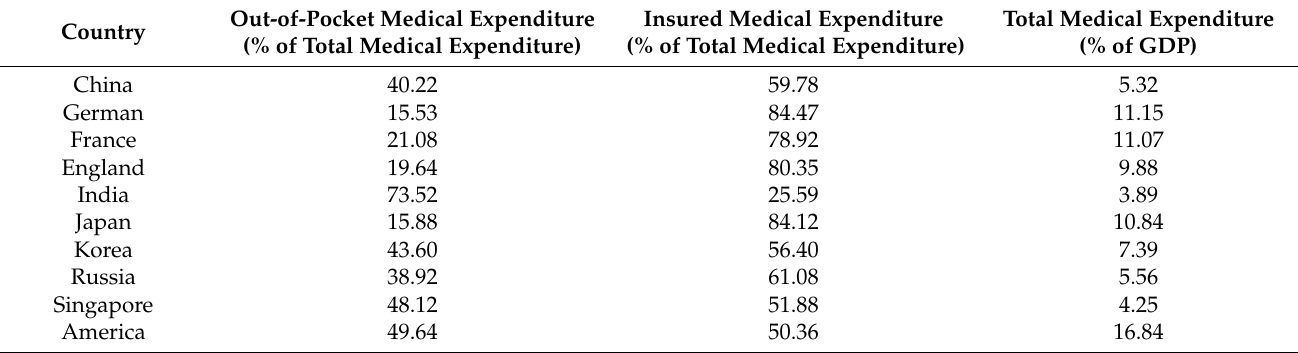
Table 4. Comparison of health expenditures in major countries in the world in